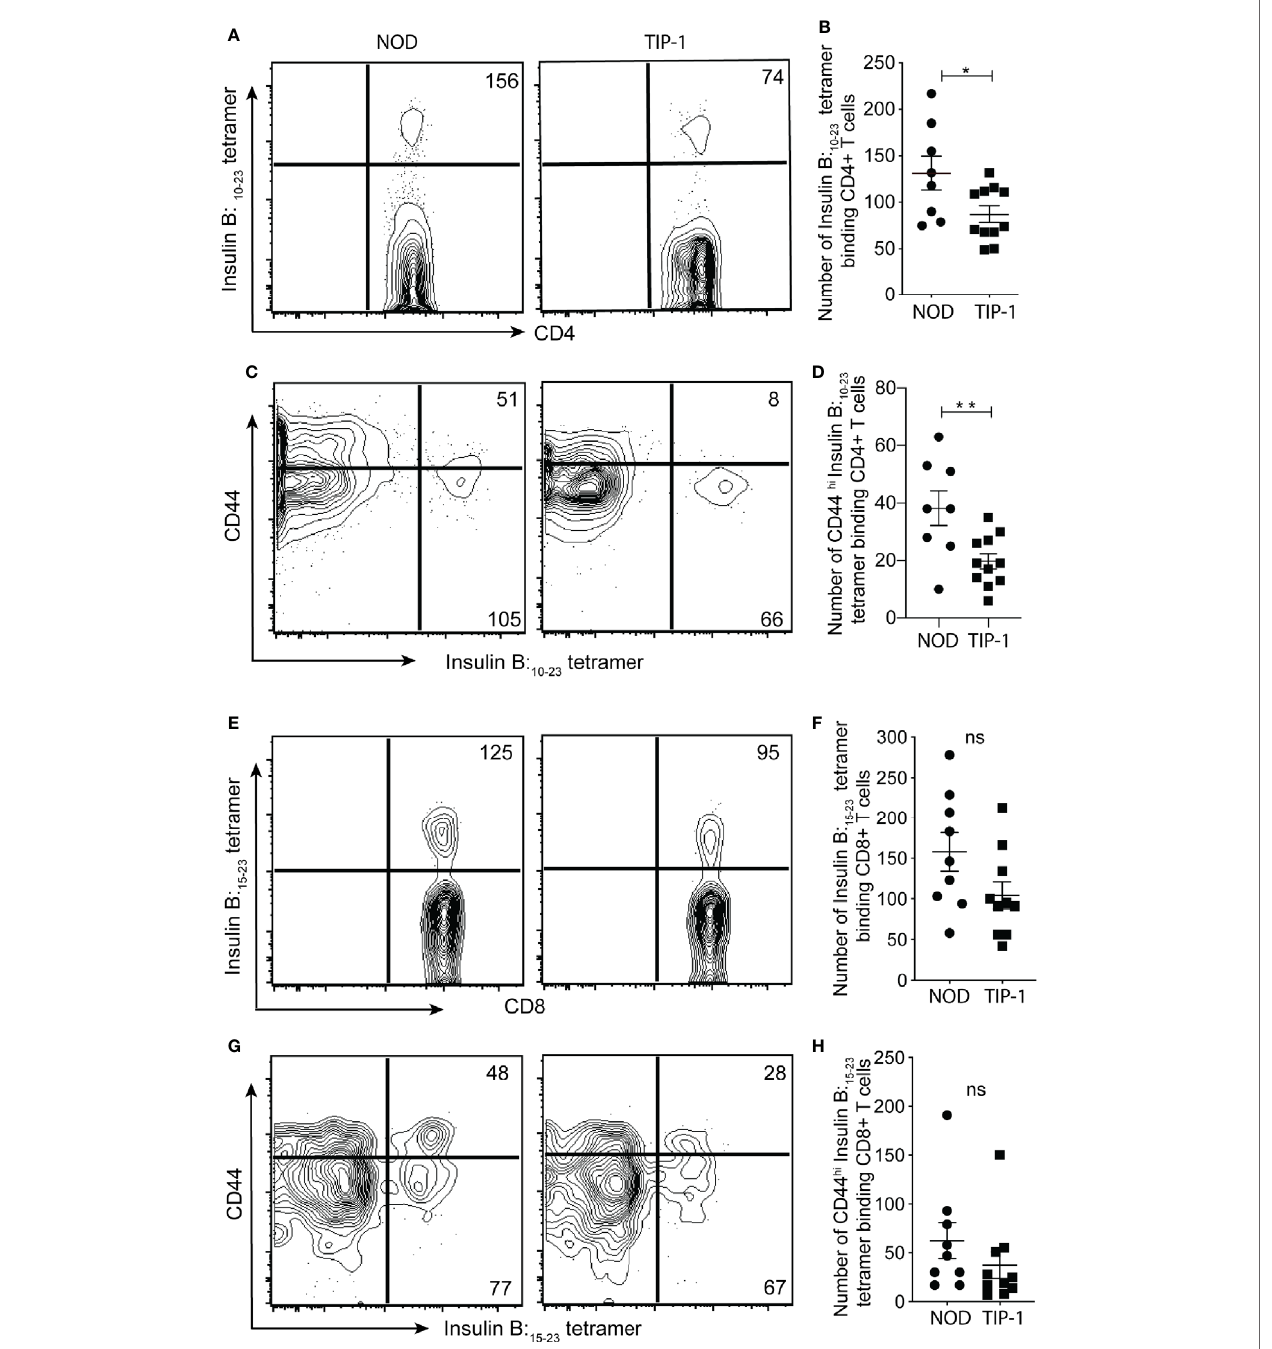
FIGURE 4 | Immune tolerance to insulin speci fi c T cells in TIP-1 mice Insulin B: 10-23 -speci fi c CD4+ T cells or Insulin B: 15-23 -speci fi c CD8+ T cells were stained with respective tetramers and enriched from pooled peripheral lymphoid organs (PLO) of 20-25 weeks old TIP-1 mice and NOD mice using magnetic beads and enumerated by fl ow-cytometry. Representative FACS plots (A, C, E, G) and enumeration of insulin tetramer+ CD4+ T (B) cells, insulin tetramer+ CD8+ T cells (F) , CD44 hi Insulin tetramer + CD4+ T cells (D) and CD44 hi Insulin tetramer + CD8+ T cells (H) in TIP-1 and NOD mice. Values in the FACS plots indicate absolute number of tetramer binding cells. Each symbol in the scatter plots (Mean ± SEM) represents data from an individual mouse. **P < 0.01, *P < 0.05, ns= not signi fi cant. Data compared using 2-tailed unpaired